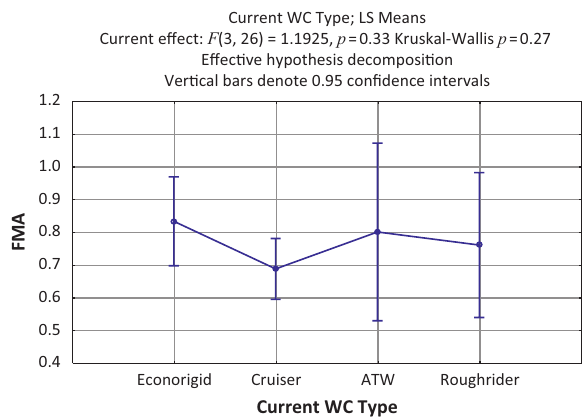
FIGURE 1: Impact of category of wheelchair on function (Kruskal-Wallis; p =